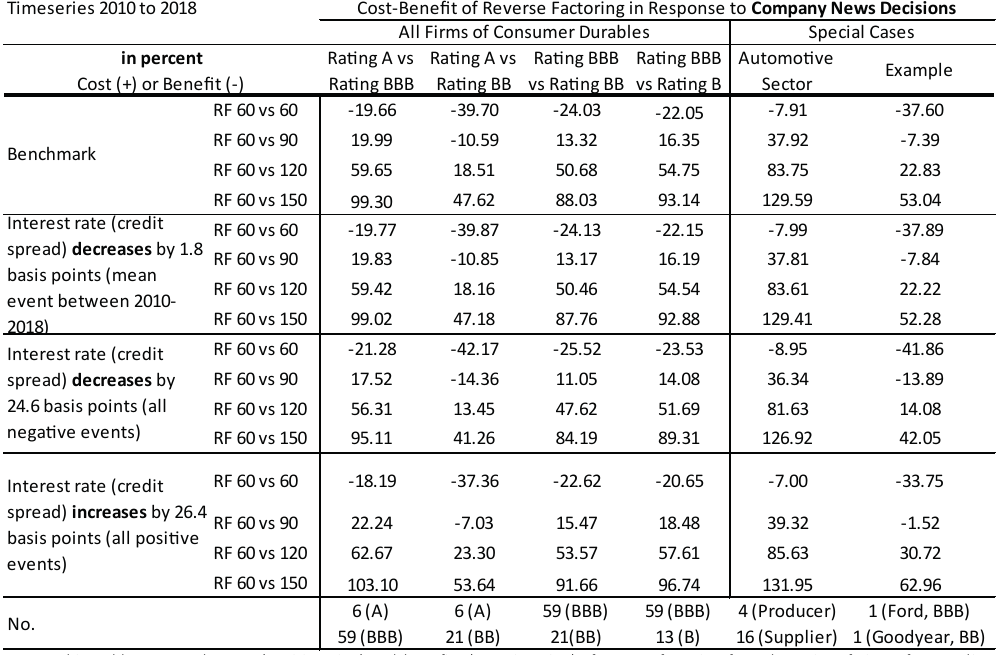
Table A3. Simulation results with corporate news events. Source: Authors, FactSet data source.